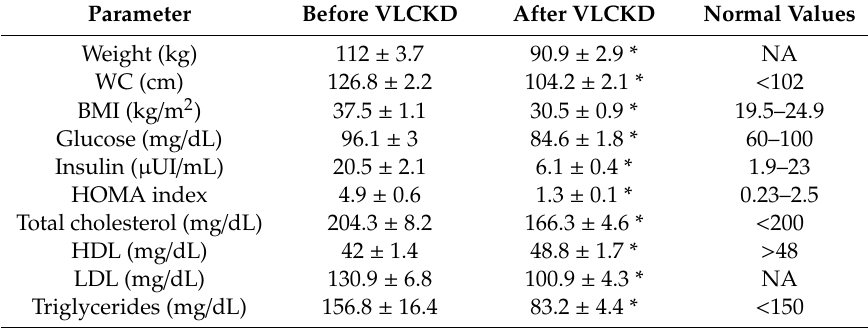
Table 1. Anthropometric, metabolic, and hormonal parameters before and after very low calorie ketogenic diet